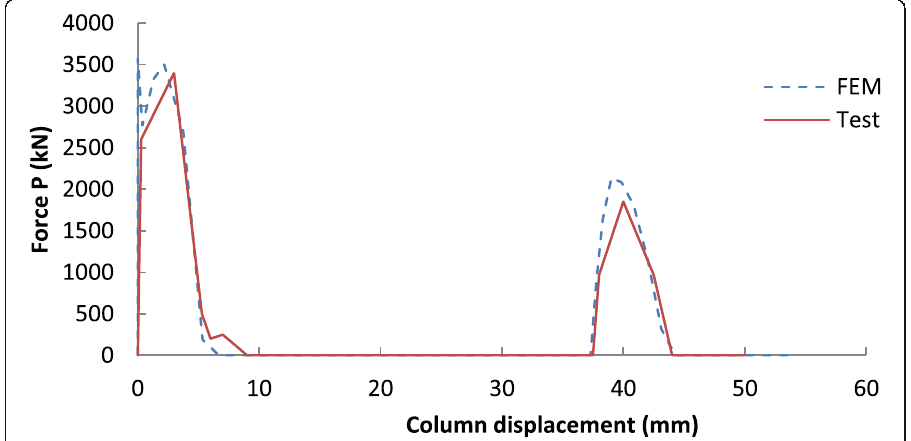
Fig. 12 Finite element vs. experimental testing for the force-column displacement